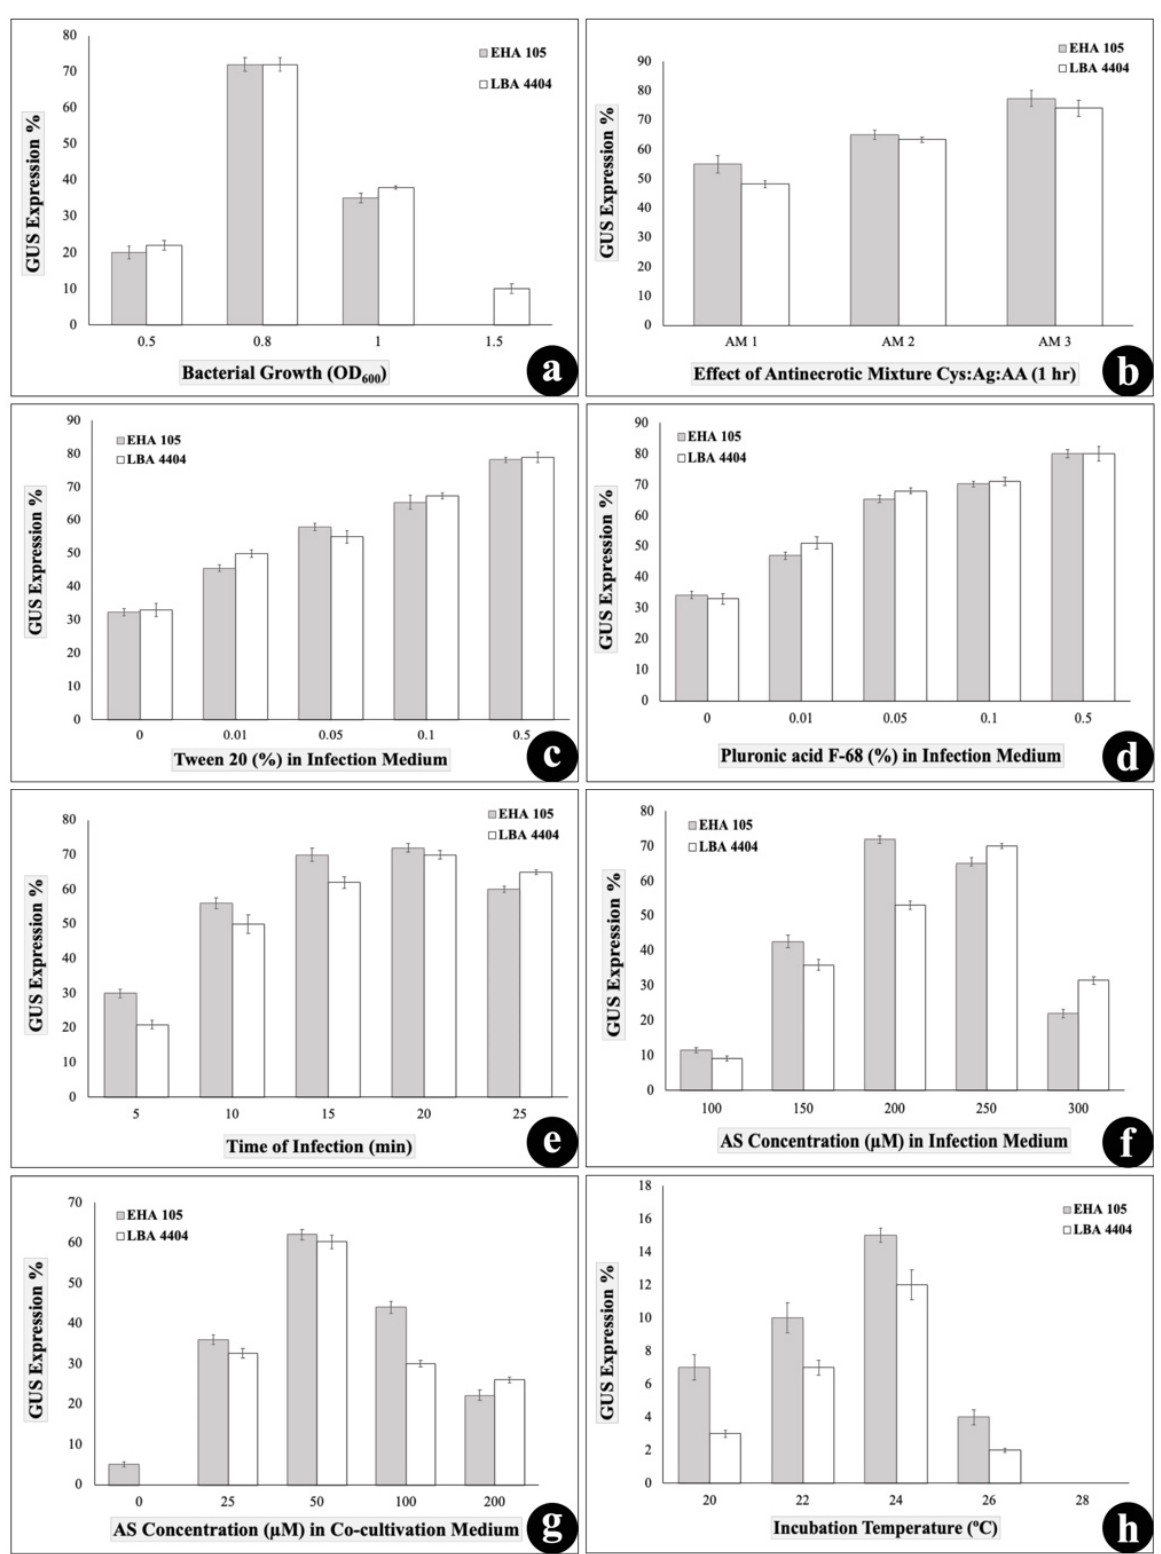
Figure 4. Effect of ( a ) Bacterial density; ( b ) Composition of antinecrotic mixture; ( c ) Concentration of Tween-20 in infection medium; ( d ) Concentration of Pluronic acid F-68 in infection medium; ( e ) Infection time; Acetosyringone concentration in ( f ) infection and ( g ) co-cultivation medium; and ( h ) Incubation temperature on GUS expression